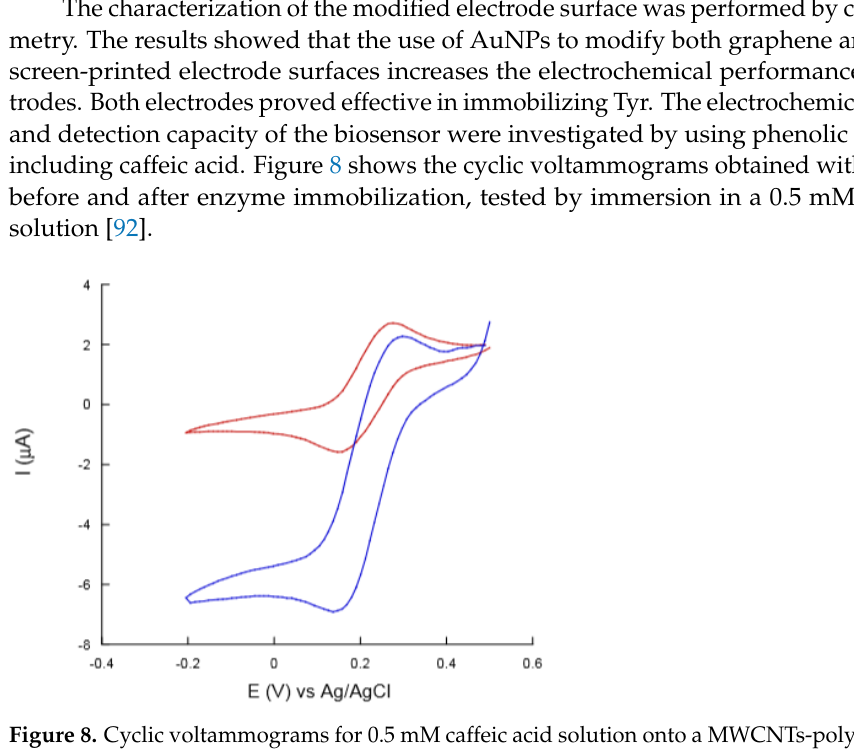
Figure 8. Cyclic voltammograms for 0.5 mM caffeic acid solution onto a MWCNTs-poly(vinylalco- hol) (PVA)-AuNPs before (red curve) and after (blue curve) laccase immobilization [92]. (PVA)-AuNPs before (red curve) and after (blue curve) laccase immobilization